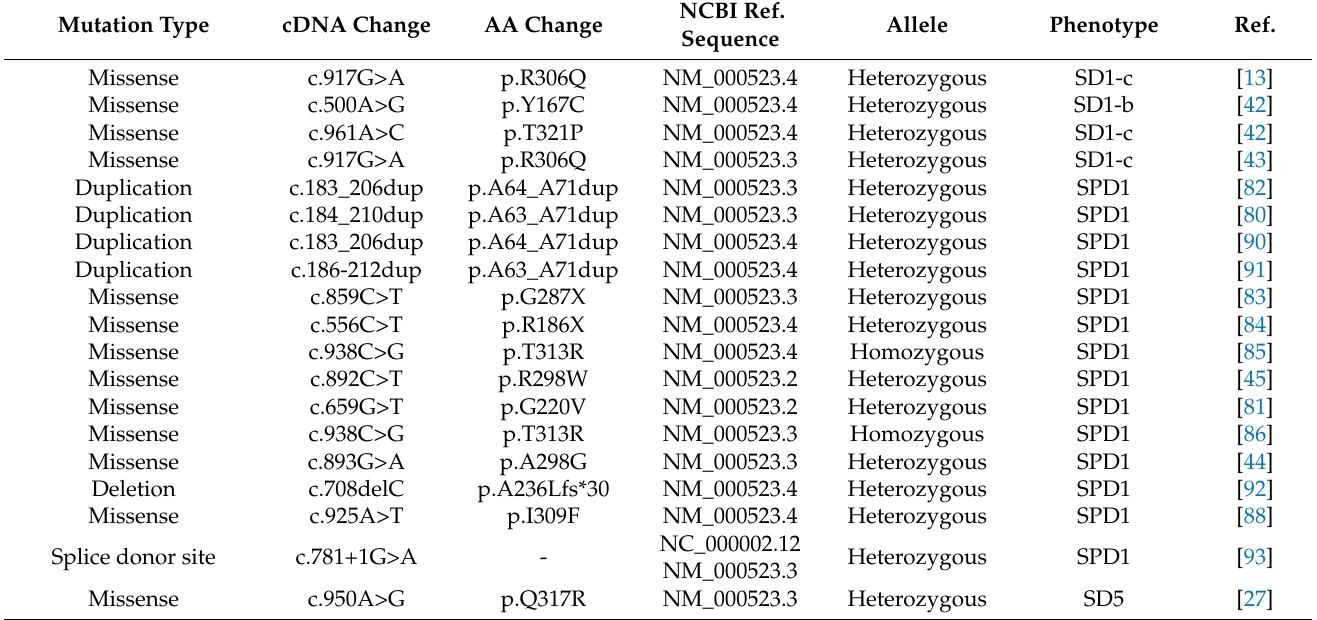
Table 3. List of HOXD13 gene mutations reported for different types of non-syndromic syndactyly in the